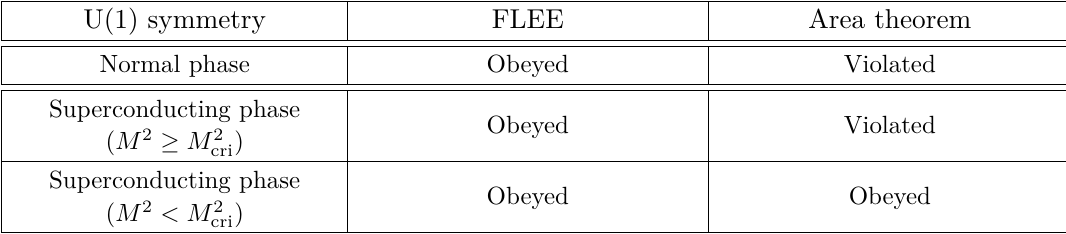
Table 1 . FLEE/area theorem with broken U(1) symmetry. The area theorem is violated at low T . M 2 ∼ − 0 . 3 cri